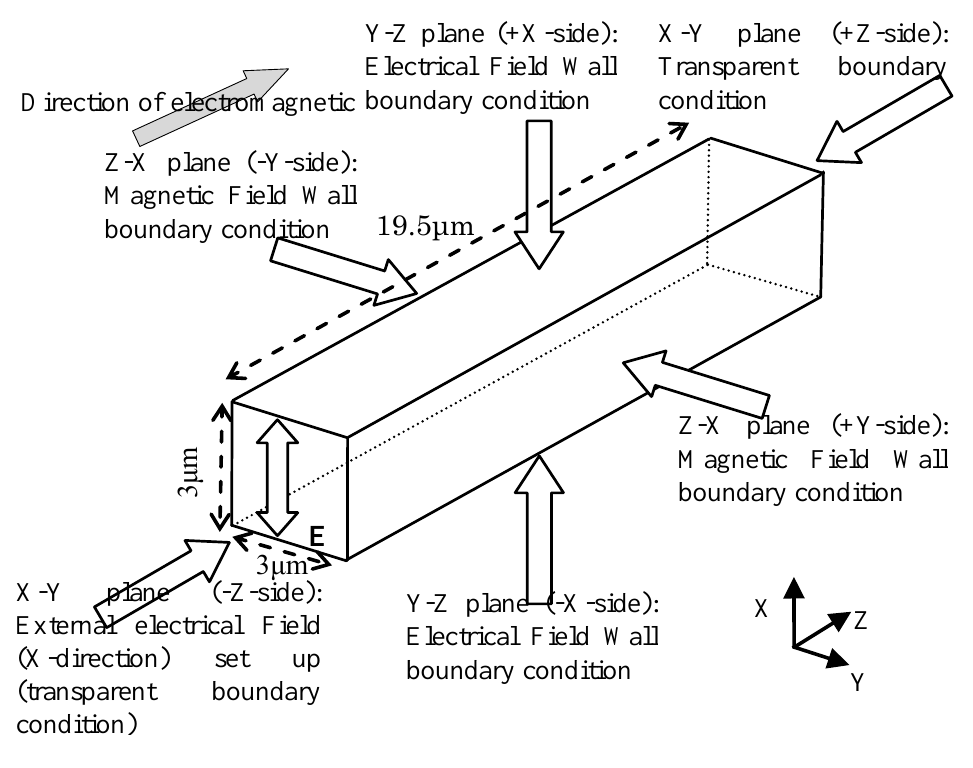
Figure 2. Boundary conditions of a micro-sized numerical model.